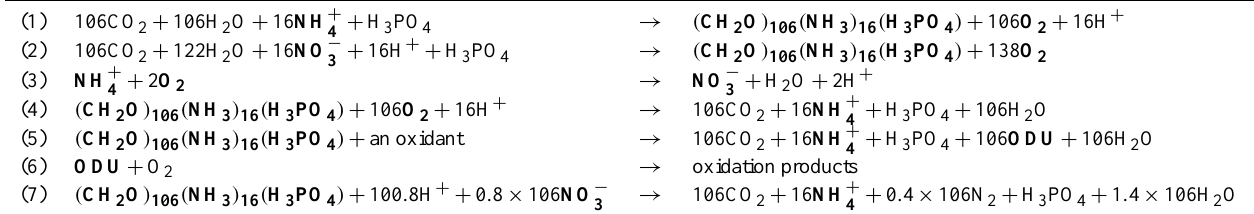
Table 4. Reaction equations used in the pelagic (1–6) and benthic (4–7) model. The compounds that are included as state variable in the model are modelled are in bold. ODU denotes oxygen demands units and is expressed in µMO 2